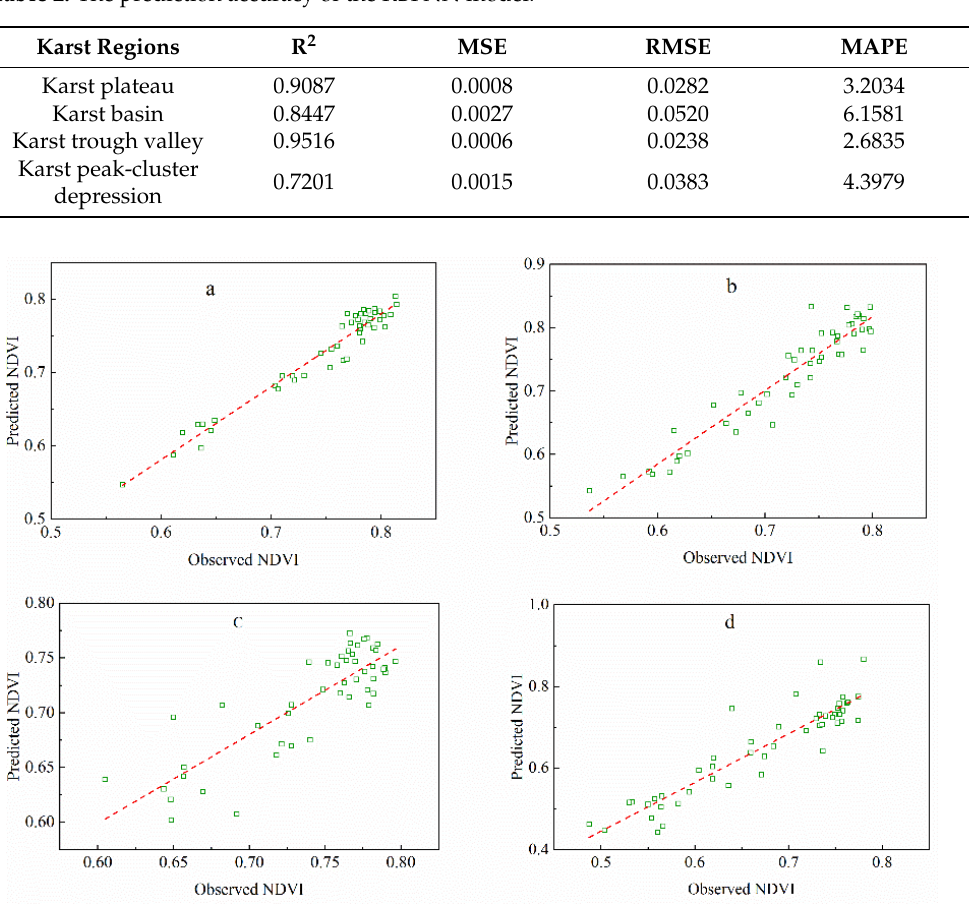
Figure 5. Comparison of the observed and RF predicted NDVI in the ( a ) karst plateau, ( b ) karst trough valley, and ( c ) karst basin, ( d ) karst peak-cluster depression.